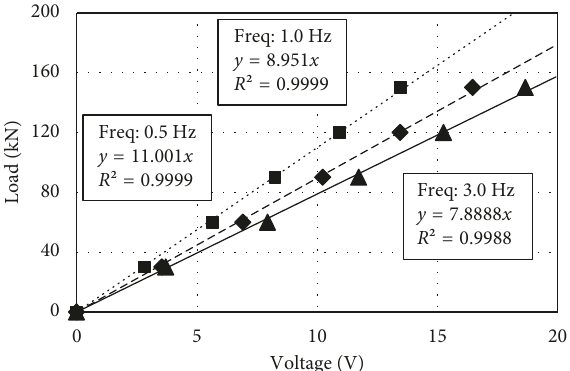
Figure 5: Output voltage-load relation of the BWIM system at various dynamic load